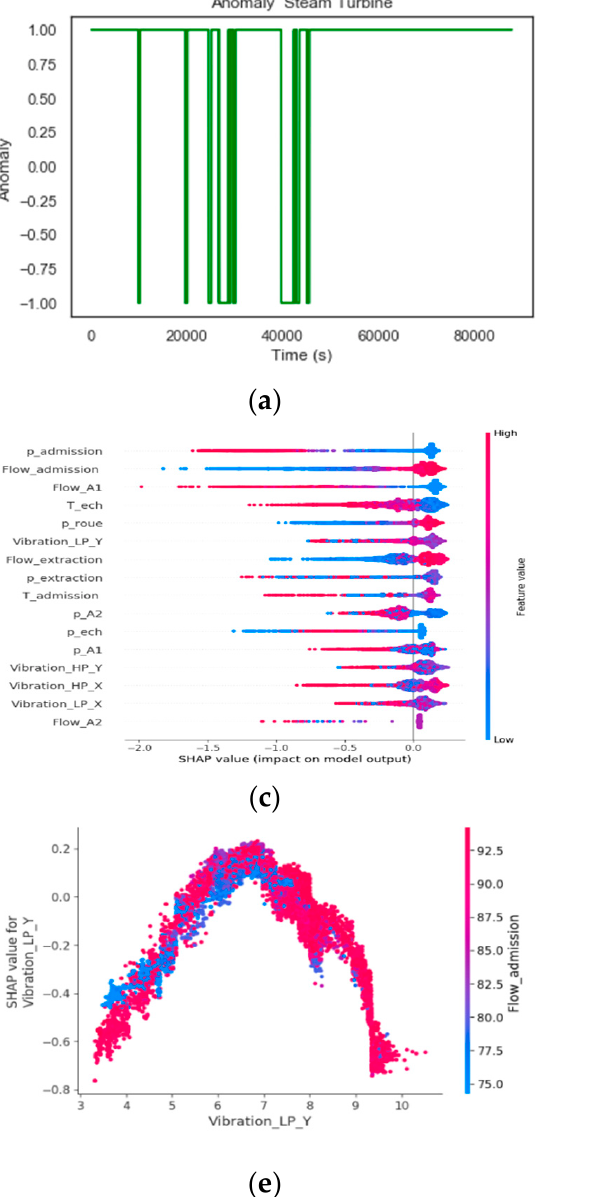
Figure 15. Anomaly forecasting according to IF for steam turbine. ( a ) Anomaly in steam turbine admission flow. ( b ) Summary plot for contribution to steam turbine detected anomalous point in testing data samples. ( c ) Dependence plot of admission wheel pressure. ( d ) Vibration LP ( e ) and exhaust temperature ( f ) on steam turbine health state and their mutual interaction with admission flow.